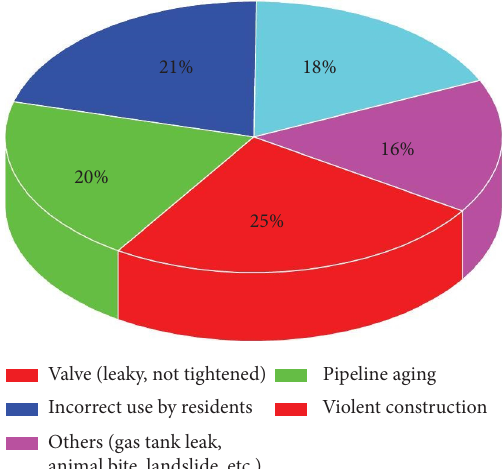
Figure 4: Statistical analysis of the causes of natural gas leakage in China in the frst quarter of 2022 (source: the domestic gas ex- plosion accidents in the frst quarter of 2022 from the National Bureau of Statistics).